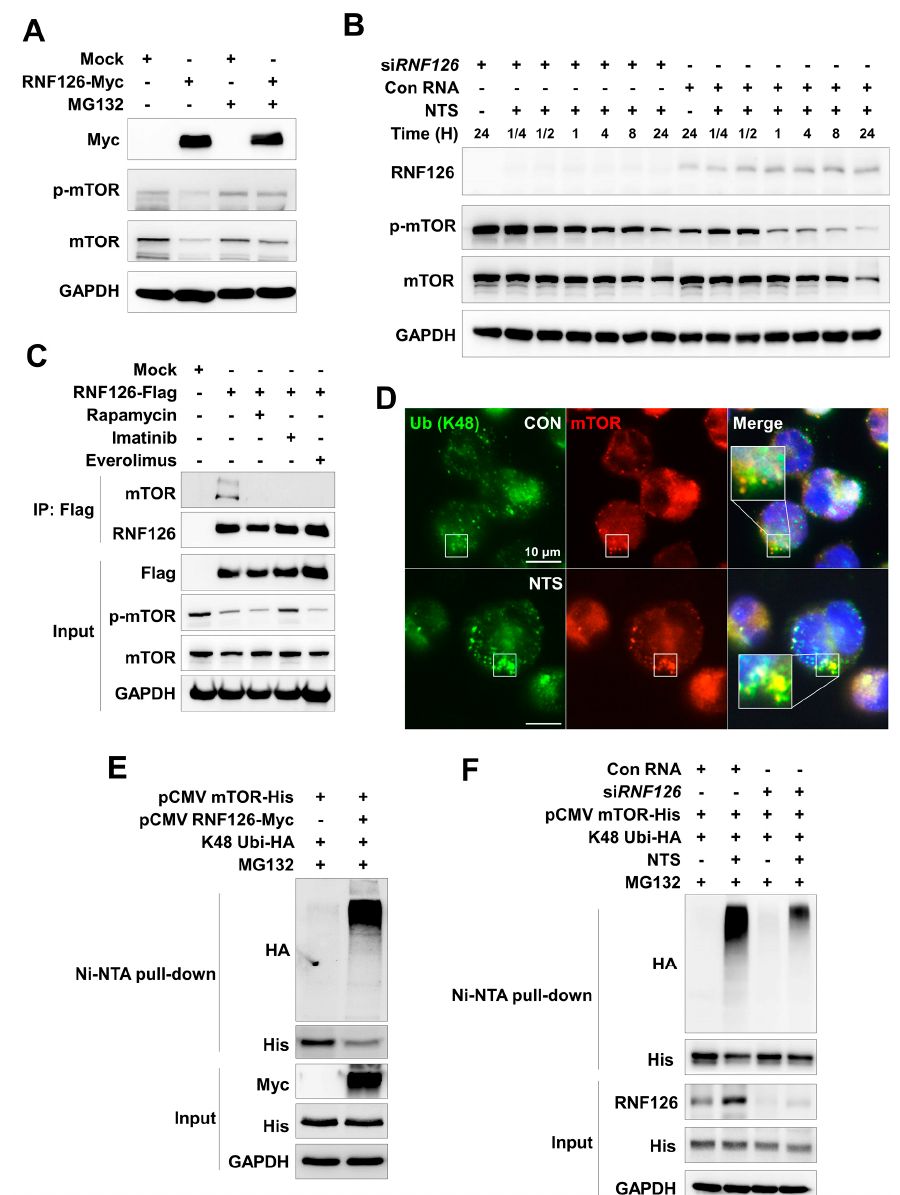
Figure 4. RNF126-induced K48-linked ubiquitination of mTOR. ( A ) Western blot of RNF126-induced proteasomal degradation of mTOR. RNF126 plasmids were transfected into K562 cells before treatment with proteasome inhibitor MG132 (10 µ M). ( B ) Western blot of early NTS-induced mTOR phosphorylation in K562 cells transfected with siRNF126 compared to non-transfected control cells. NTS induces degradation of p-mTOR and mTOR through RNF126 dependently. ( C ) Interaction between mTOR and RNF126 evaluated by immunoprecipitation assay. K562 cells were transfected with RNF126 plasmids then treated with mTOR inhibitors, Rapamycin, Imatinib, or RAD001 for 24 hours. ( D ) NTS-induced K48-linked ubiquitination of mTOR in K562 cells treated with NTS. Endogenous K48-linked ubiquitin (green) or mTOR (red) were stained with anti-K48 ubiquitin or anti-mTOR antibodies. Scale bar-10 µ m. ( E ) RNF126-induced K48-linked ubiquitination of mTOR in K562 cells transfected with each indicated plasmid and treated with MG132 (10 µ M) proteasome inhibitor. mTOR ubiquitination was determined by Ni-NTA His pull-down assay. ( F ) Ni-NTA His pull-down assay of mTOR ubiquitination in RNF126-suppressed cells. The indicated plasmids were transfected and then NTS was added for a further 24 hours. MG132 (10 µ M) was added for 6 hours before cell